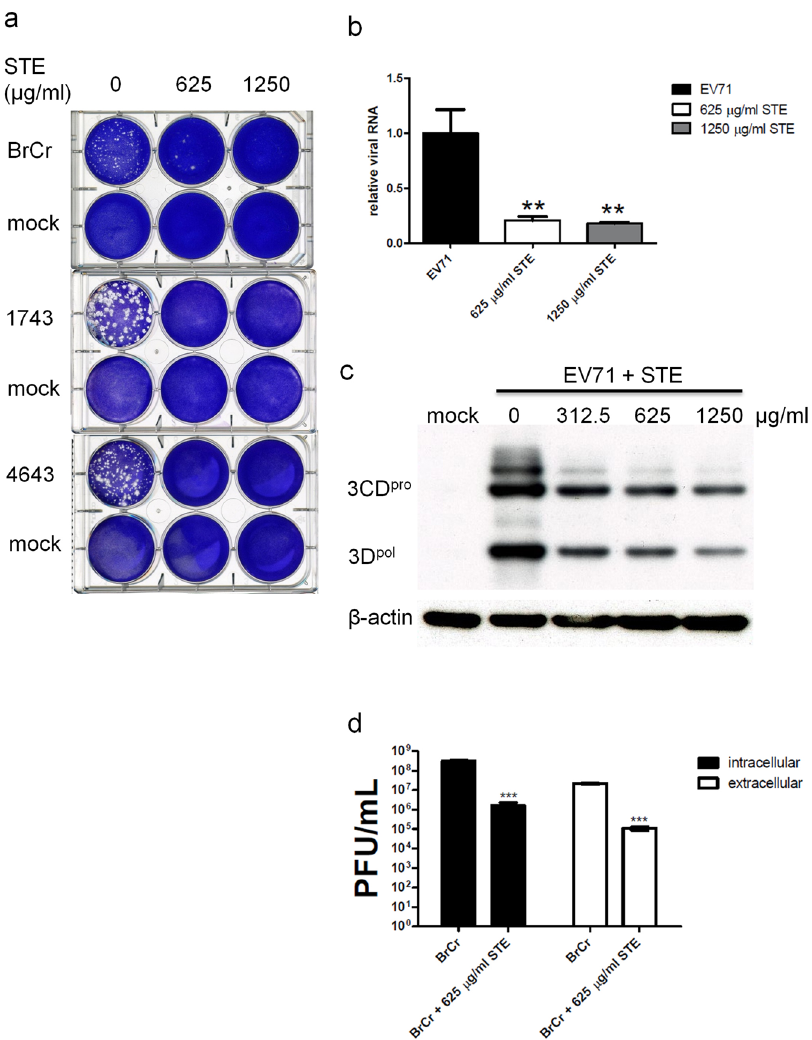
Figure 1. Anti-EV71 activity of STE. ( a ) RD cells were mock- or infected with 100 PFU of EV71 strains, namely BrCr, 1743 and 4643 for 1 h, and were overlaid with 0.3% agarose in DMEM/2% FBS, which was supplemented with 0, 625, or 1250 µ g/ml of STE. After 96 h, the plates were fixed with 10% formalin, and stained with 1% crystal violet solution. Representative cell plates are shown here. ( b ) RD cells were infected with BrCr at m. o. i. of 0.05 in the absence or presence of 625 and 1250 µ g/ml STE for 16 h. The level of EV71 genomic copy was determined by quantitative reverse transcription PCR, and normalized to the level of β -actin. Data are expressed relative to that of untreated cells. The results are means ± SD of three separate experiments. ** P < 0.01, vs. infected cells without treatment. ( c ) RD cells were infected with BrCr at m. o. i. of 5 in the presence of indicated concentrations of STE. Cellular protein was harvested at 6 h p. i., and was subject to western blotting with antibodies to 3D and β -actin. The cropped images of the blots are shown. A representative experiment out of three is shown. ( d ) RD cells were infected with BrCr as described in ( c ), and treated without or with 625 µ g/ml STE. Extracellular and intracellular viral particles were collected at 9 h p. i. for titer determination. The results are means ± SD of three separate experiments. *** P < 0.0001, vs. infected cells without